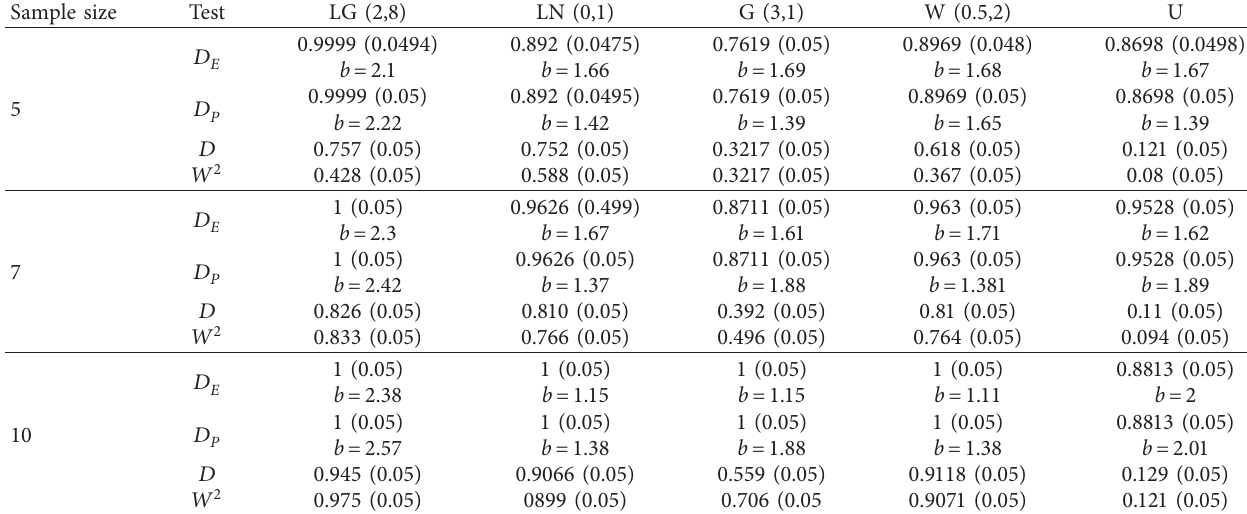
Table 1: Monte Carlo power estimates of the tests at 5 percent significant level with null distribution function Power (1,2). Sample size